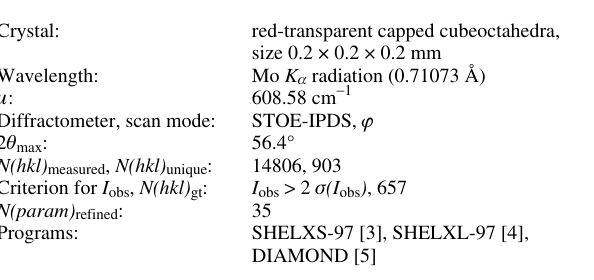
Table 3. Data collection and handling.